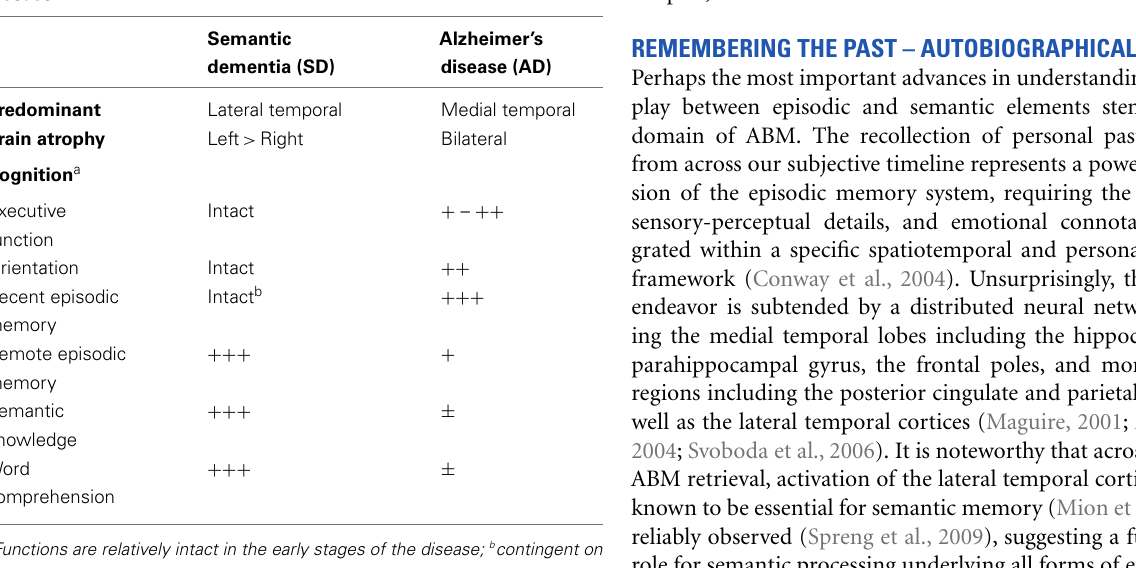
Table 1 | Clinical characteristics of semantic dementia andAlzheimer’s